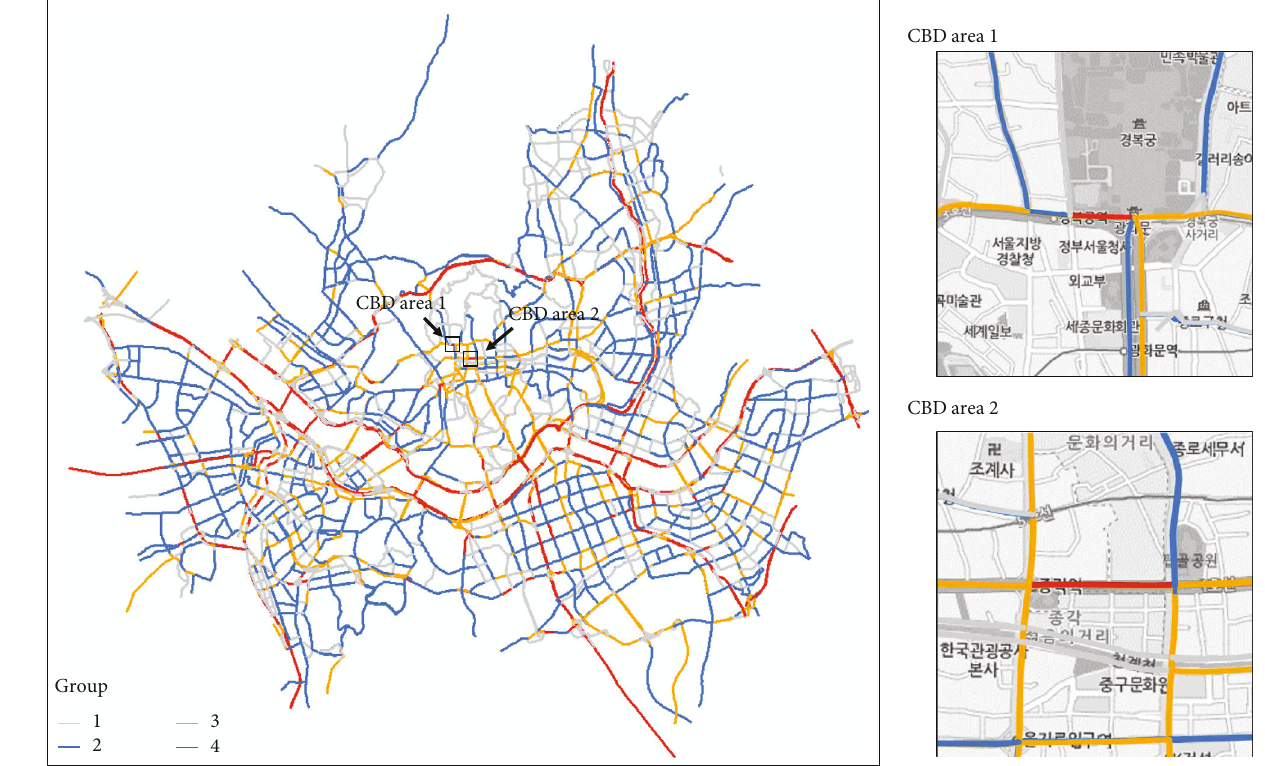
Figure 7: Spatially visualized result of clustering in Seoul City and examples of link